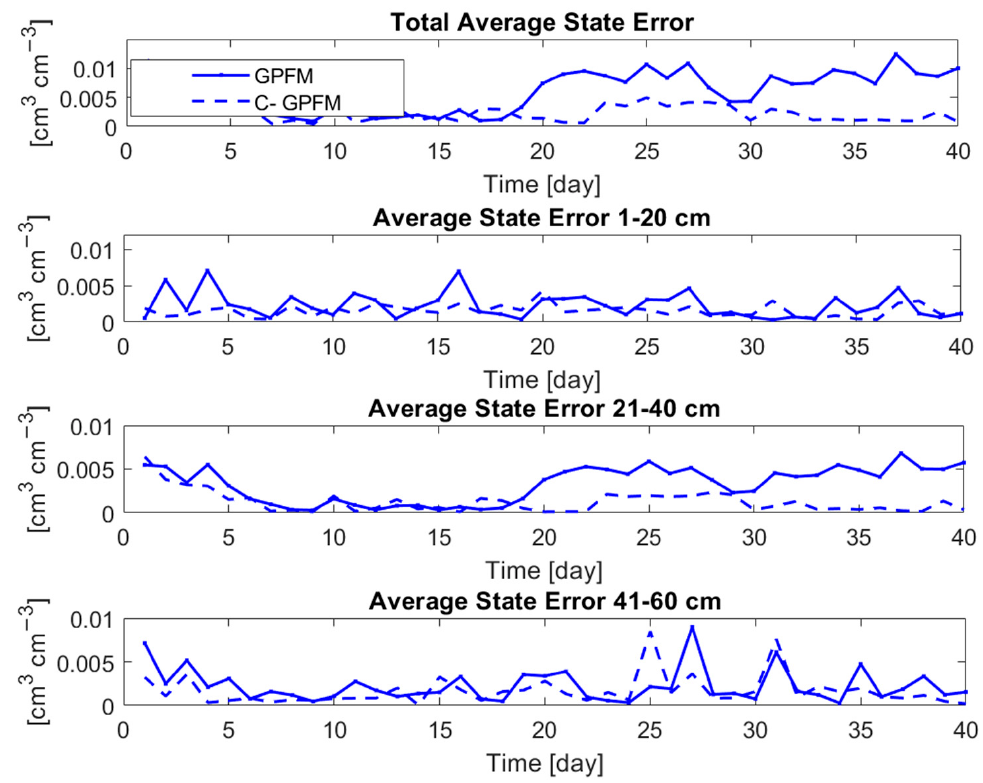
Figure 3. Average of parameters posteriors by C-GPFM and GPFM together with the ‘true’ and ‘biased’ values for Case Study #1.